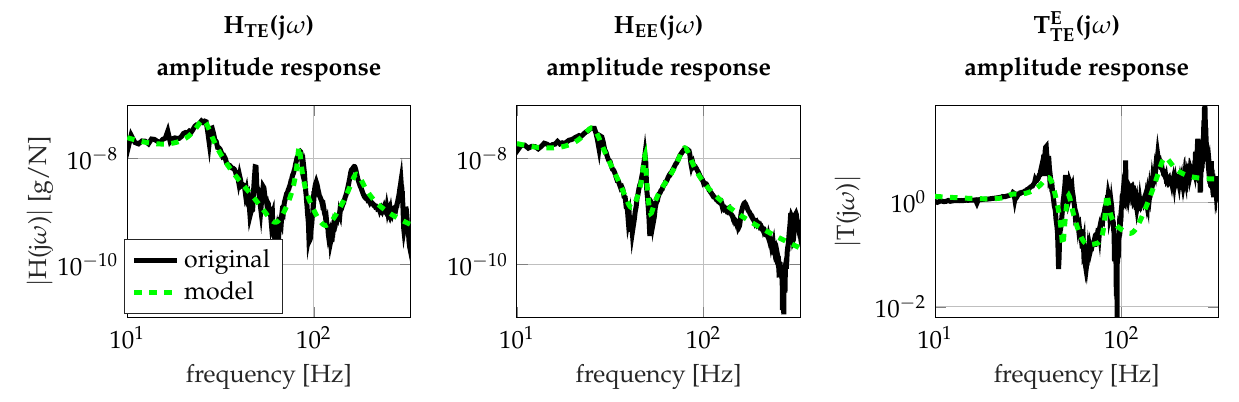
Figure 8. TMF build out of two regular FRFs.